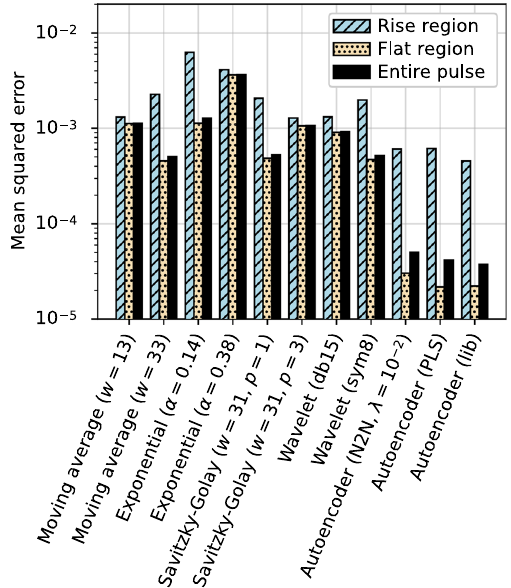
Fig. 5 Mean squared error comparison of different noise removal methods inside and outside the rise region of the pulse (defined in the text and shown in Fig. 4). The mean squared error inside the rise region isindicatedbytheslantedlinehatchwhileoutsidetheriseregionisindi- cated by the dotted hatch. Solid fill corresponds to the mean squared error over the entire pulse